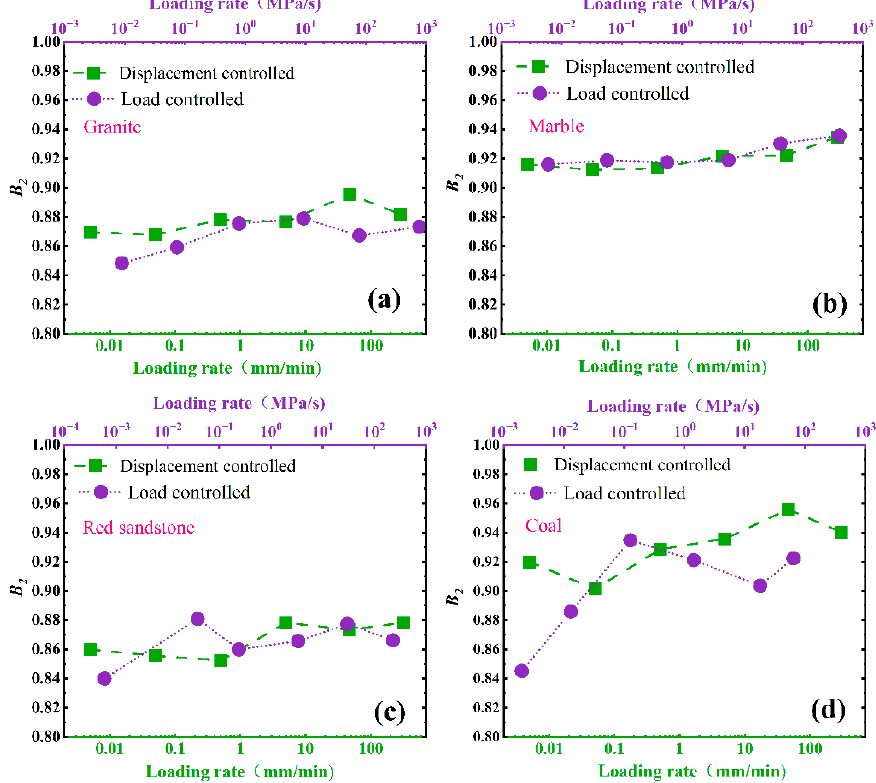
Figure 7. E ff ect of loading mode on B 2: ( a ) granite, ( b ) marble, ( c ) red sandstone, ( d ) coal For 𝑆𝐷𝑅 , the control mode has great in fl uence on the SDR . For granite, marble and coal, the values of the SDR under the load control mode are bigger than that of the SDR under displacement control mode. While for marble, the values of the SDR under displacement control mode are bigger than that of the SDR under loads control mode (Figure 8).